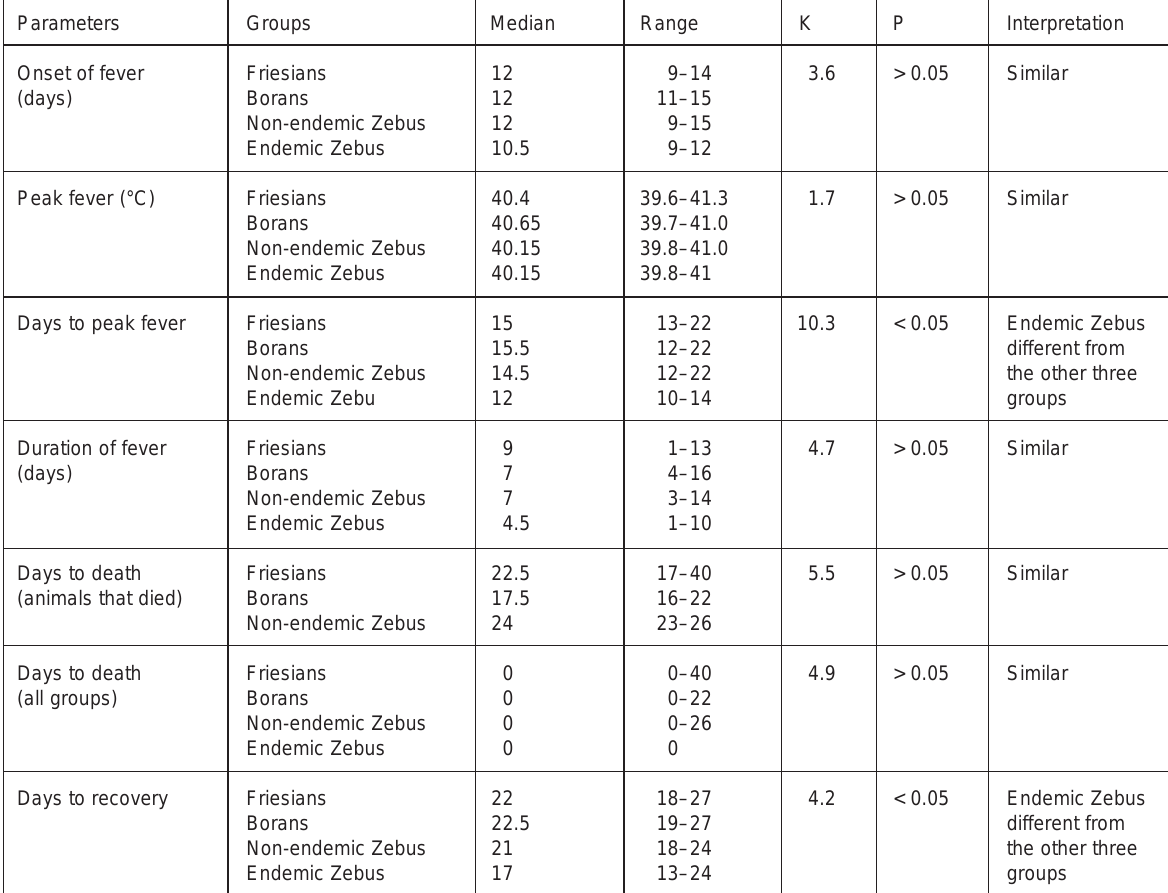
TABLE 1 Comparisons of clinical parameter